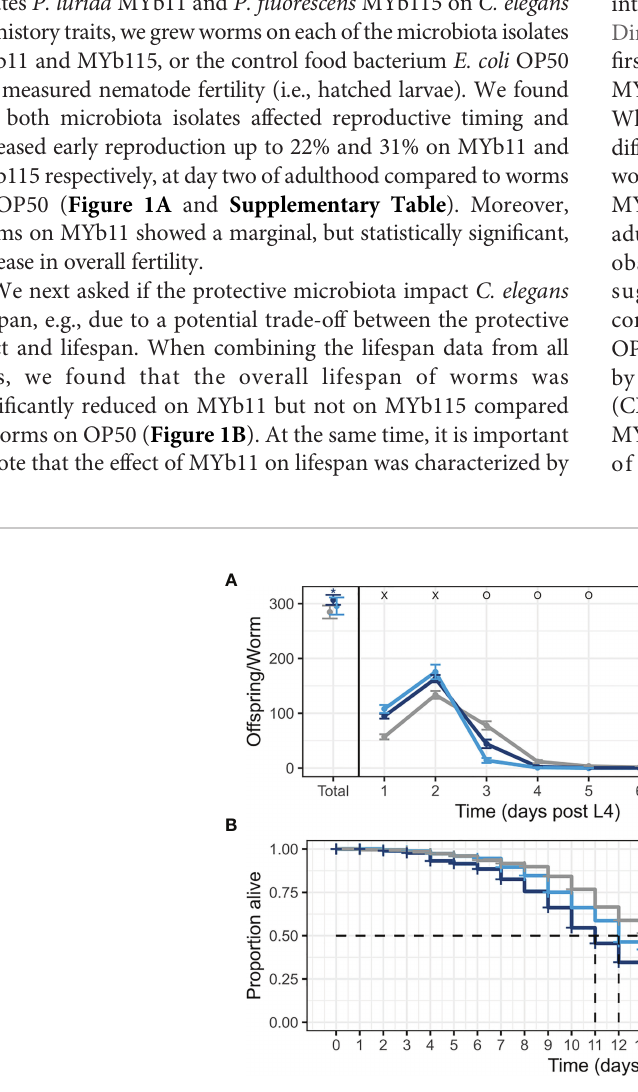
FIGURE 1 | MYb11 and MYb115 affect reproductive timing, and MYb11 affects fertility and lifespan. (A) Daily brood size (hatched offspring) of C. elegans exposed to the two natural microbiota isolates, P. lurida MYb11 and P. fl uorescens MYb115, compared to worms exposed to the food bacterium E. coli OP50. Hatched offspring were counted every day until the worms did not produce any more offspring for two consecutive days. Presented here are pooled data combined from 5 independent experiments (n= 75 (OP50), n=69 (MYb11), n=43(MYb115), also see Supplementary Table ). “ x ” indicates signi fi cantly higher hatched offspring for worms on the natural microbiota isolates, while “ o ” indicates signi fi cantly higher numbers for worms on OP50. * p < 0.05, as determined by Kruskal-Wallis test, with Wilcoxon pairwise comparison and FDR correction. (B) Lifespan analysis of C . elegans N2 under different bacterial conditions on PFM plates. Alive, dead, and missing worms were counted until all worms were dead, i.e., failed to respond to the light touch of a platinum wire picker. Shown are pooled data combined from four independent experiments (n=573 (OP50), n=459 (MYb11), n=554 (MYb115), also see Supplementary Table ). P- values were determined with Kaplan-Meier analysis and log-rank test, and are considered signi fi cant according to: * p < 0.05. Horizontal ticks represent censored data (missing